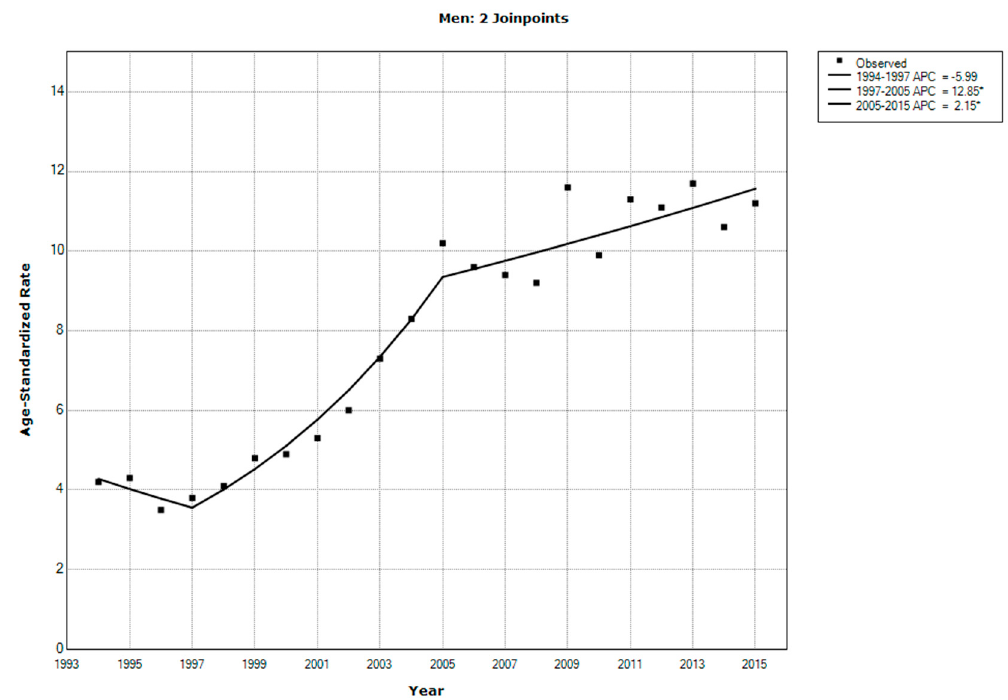
Figure 1. Trends in the age-standardized incidence rates for colorectal cancer among men in Saudi Arabia, 1994–2015. * indicates that the annual percent change is significantly different from zero at the alpha = 0.05 level. Final selected model: 2 Joinpoints.